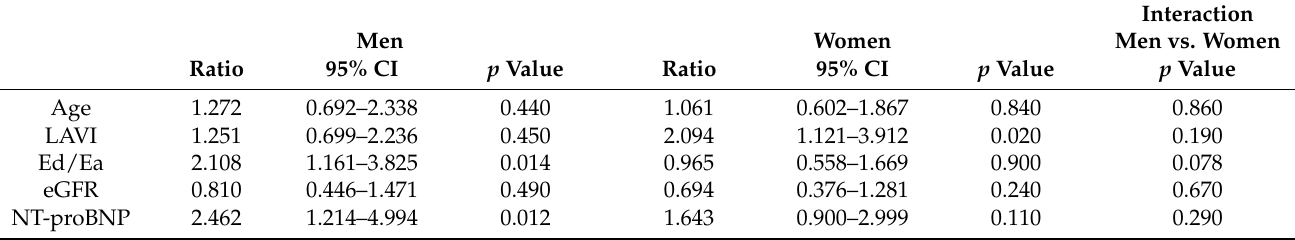
Table 4. Between-sex differences in prognostic variables for re-admission for heart failure during the first year in a multivariable Fine–Gray